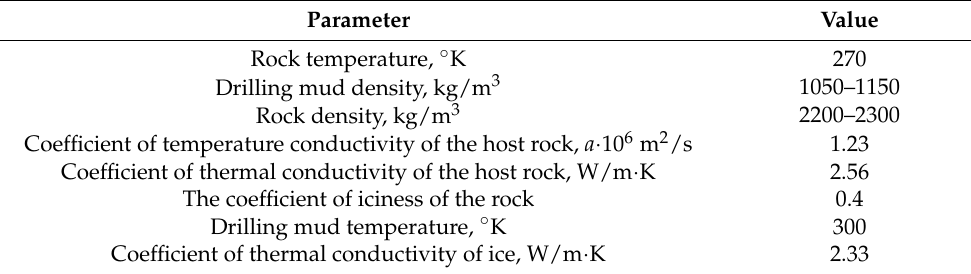
Table 1. Values of physical parameters of the model taken as a constant value.